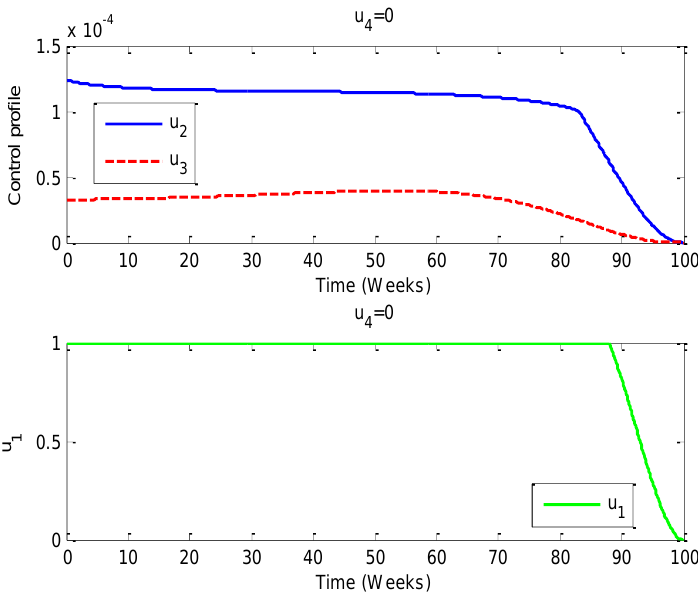
Figure 6. Control profile for implementation of triple optimal